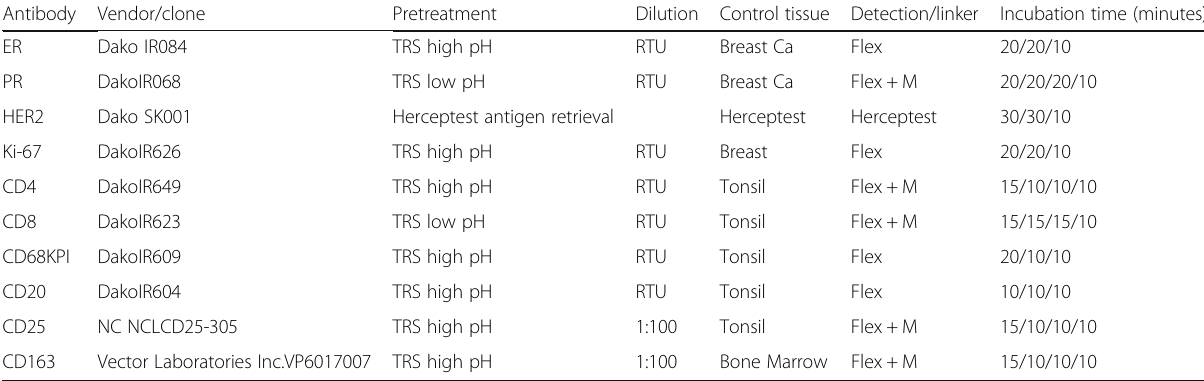
Table 1 List of primary antibodies Antibody Vendor/clone